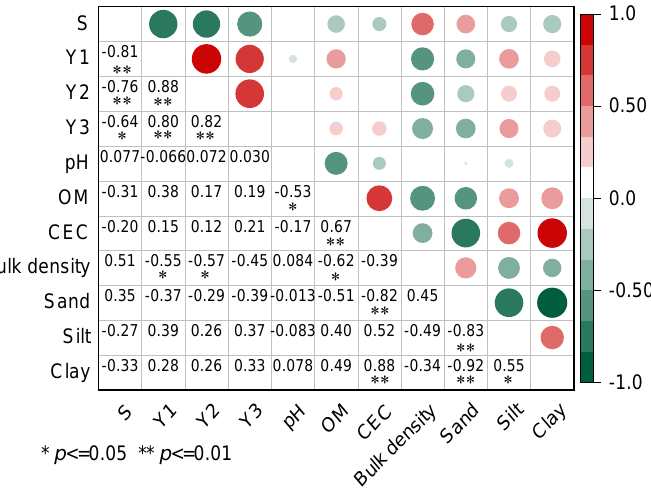
Figure 4. Correlation analysis between physiochemical properties, migration distance, and residual amount of diesel in the 0 – 3 cm soil layer.